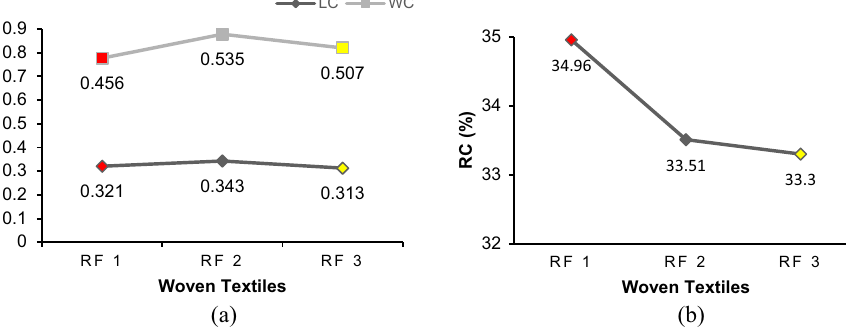
Fig. 10 a Linearity of compression (LC) and compressional energy (WC—gf.cm/cm 2 ) and b compressional resilience (RC—%). RF Reflective